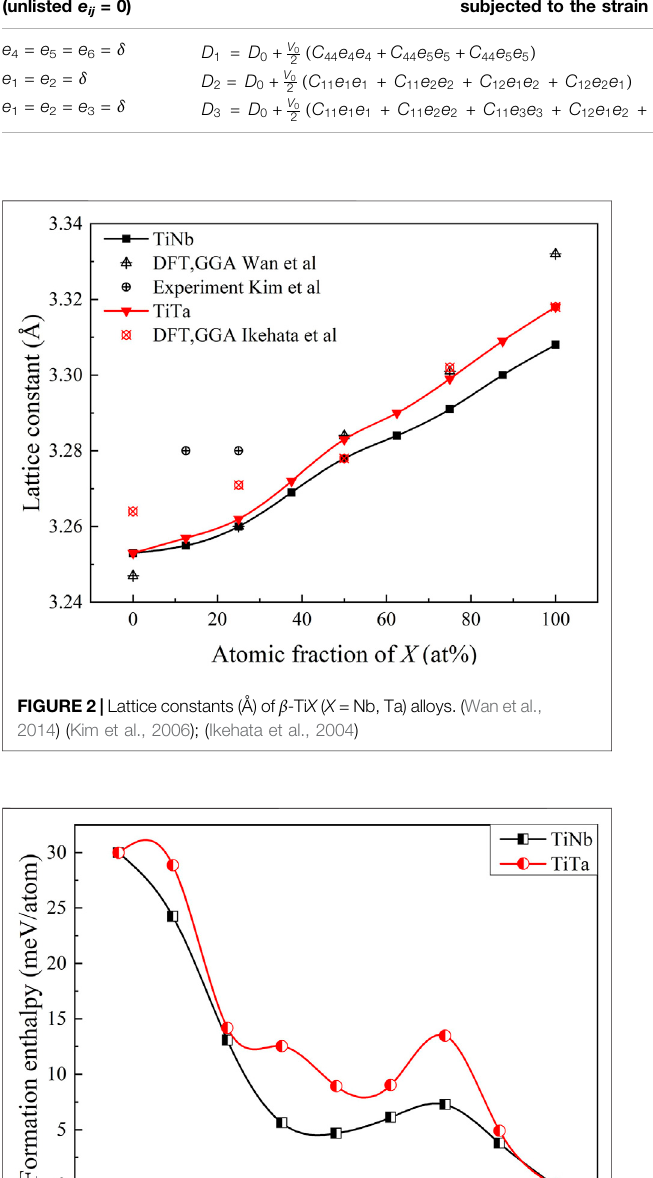
The energy of the cubic crystal subjected to the strain on the left column